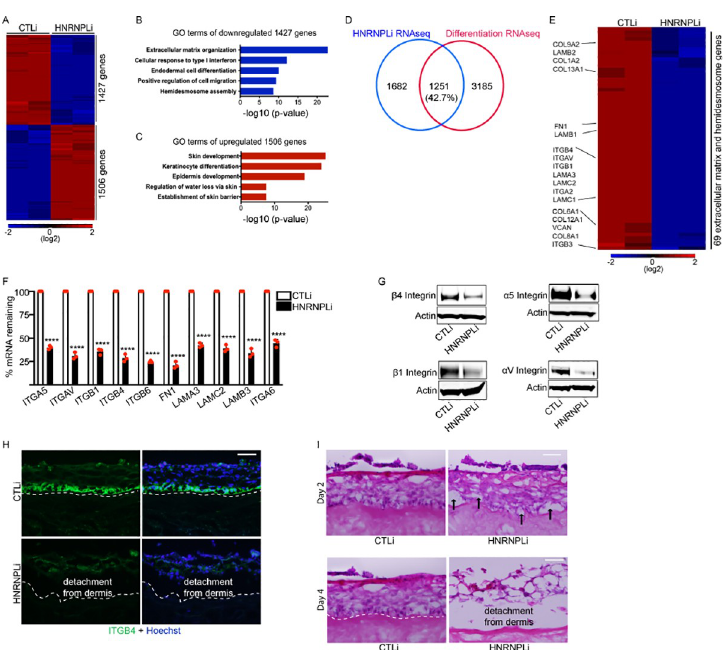
Fig 2. HNRNPL promotes the expression of integrin and ECM genes to allow attachment of the epidermis to dermis. (A) RNA-seq analysis of CTL and HNRNPL knockdown primary human keratinocytes (day 4). RNA-seq results were performed in duplicates. A total of 1,506 genes were up-regulated (red), and 1,427 genes were down- regulated (blue) upon HNRNPL depletion. Heatmap is shown in log2 scale. (B) GO terms for the 1,427 genes down- regulated in HNRNPLi cells. (C) GO terms for the 1,506 genes with increased expression upon HNRNPL loss. (D) Overlap of the HNRNPL knockdown gene expression signature with the differentiation signature. (E) Heatmap showing the 69 ECM and hemidesmosome genes down-regulated upon HNRNPL knockdown. Heatmap is shown in log2 scale. (F) RT-qPCR for integrin and ECM gene expression in CTLi and HNRNPLi cells after 4 days of knockdown. qPCR results were normalized to L32 levels. Mean values are shown with error bars = SD and ���� p < 0.0001 ( t test). (G) Western blot for α and β integrin protein levels in CTLi and HNRNPLi cells. Representative images are shown. (H) Immunostaining of CTLi or HNRNPLi regenerated human skin (day 4) with β 4 integrin (ITGB4: green). Nuclei are shown in blue (Hoechst staining). The dashed white lines denote the basement membrane zone. Scale bar = 40 μ m. (I) Time course (days 2 and 4) of human skin regeneration. Hematoxylin–eosin staining of regenerated CTLi and HNRNPLi human skin. Black arrowheads denote areas of epidermal detachment from the dermis. Scale bar = 40 μ m. N = 3 independent experiments for Fig 2 unless otherwise specified. Primary data for this figure can be found in S1 Data. ECM, extracellular matrix; GO, gene ontology; HNRNPL, heterogeneous nuclear ribonucleoprotein L; RNA-seq, RNA sequencing; RT-qPCR, reverse transcription quantitative PCR.